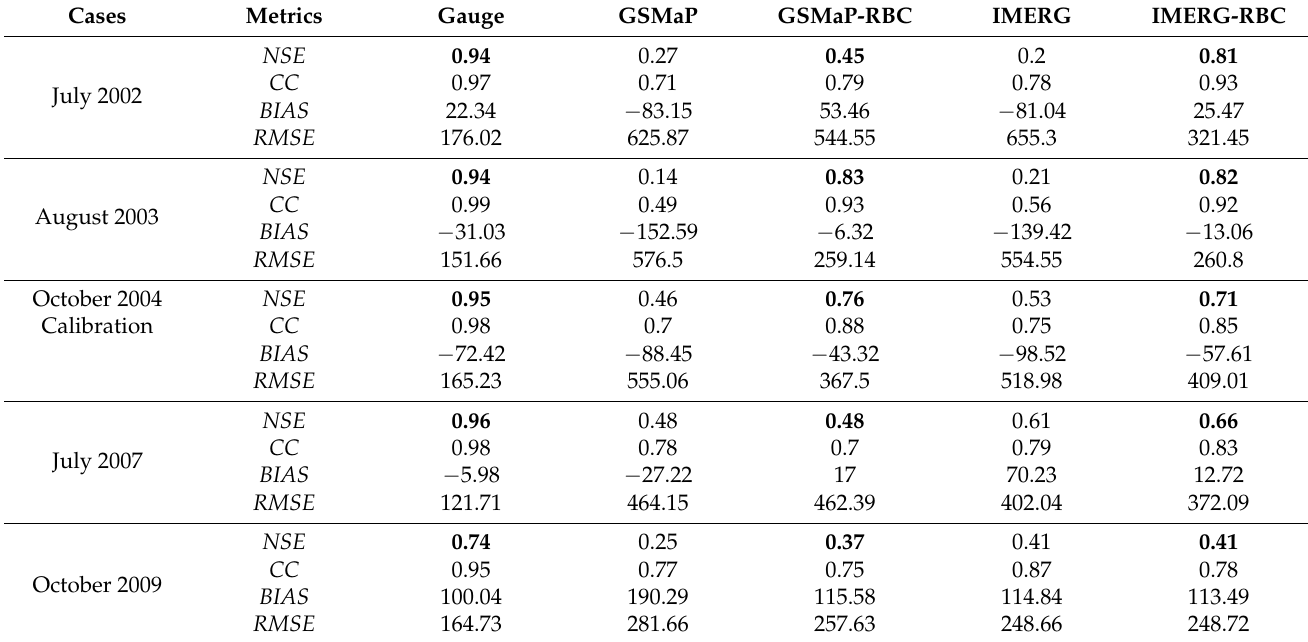
Table 2. Evaluation criteria for flood discharge